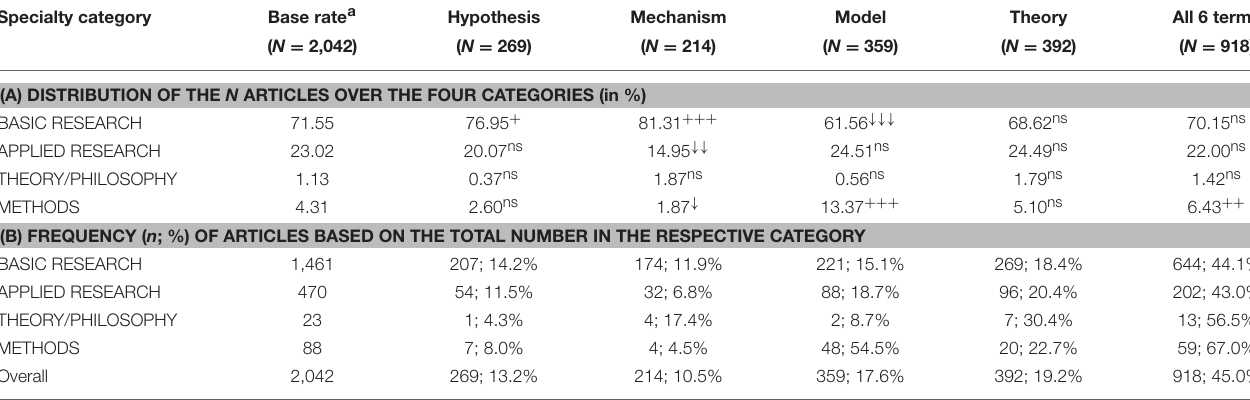
TABLE 5 | Distribution of all articles ( base rate ) and of five subsets of articles referring to different theory-related terms over four specialty categories. Specialty category